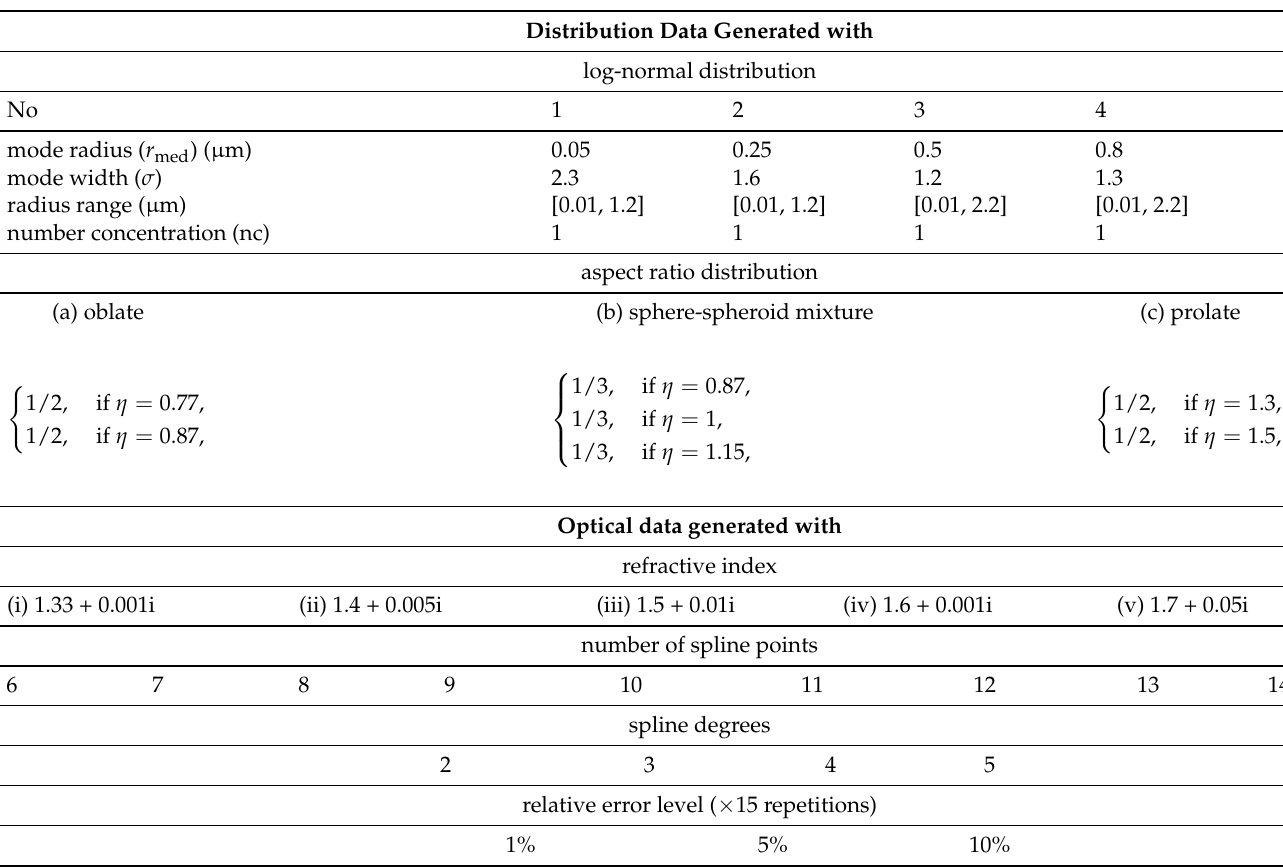
Figure 2. 2D-Plots of synthetic shape-size distributions produced by combinations of log-normal distributions and aspect ratio distributions from Table 2, see the corresponding title above each plot. Table 2. Simulation- and inversion setup with a fixed refractive index. Parameters below the titles “Distribution data generated with”, “Optical data generated with” and “Optical data inverted with” are combined with each other to perform the corresponding